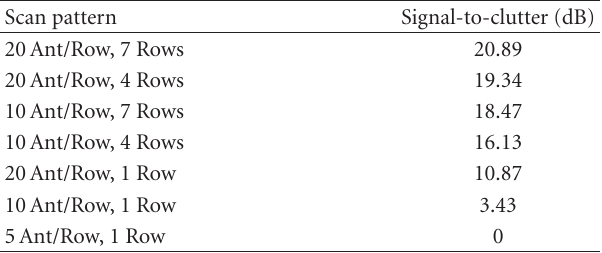
Table 2: Comparison of SCR for di ff erent scan